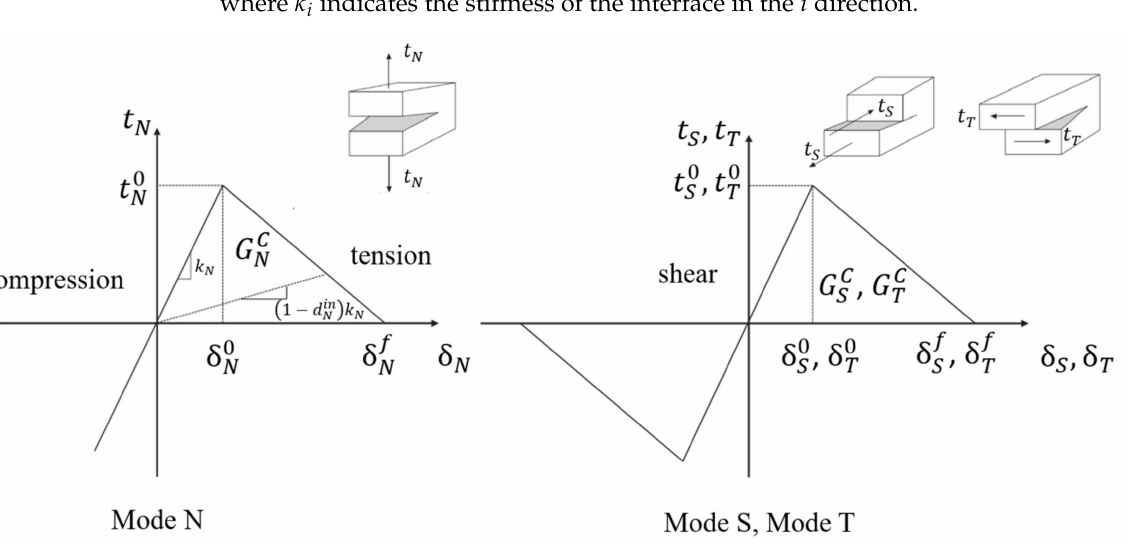
Figure 6. Delamination mode of the cohesive